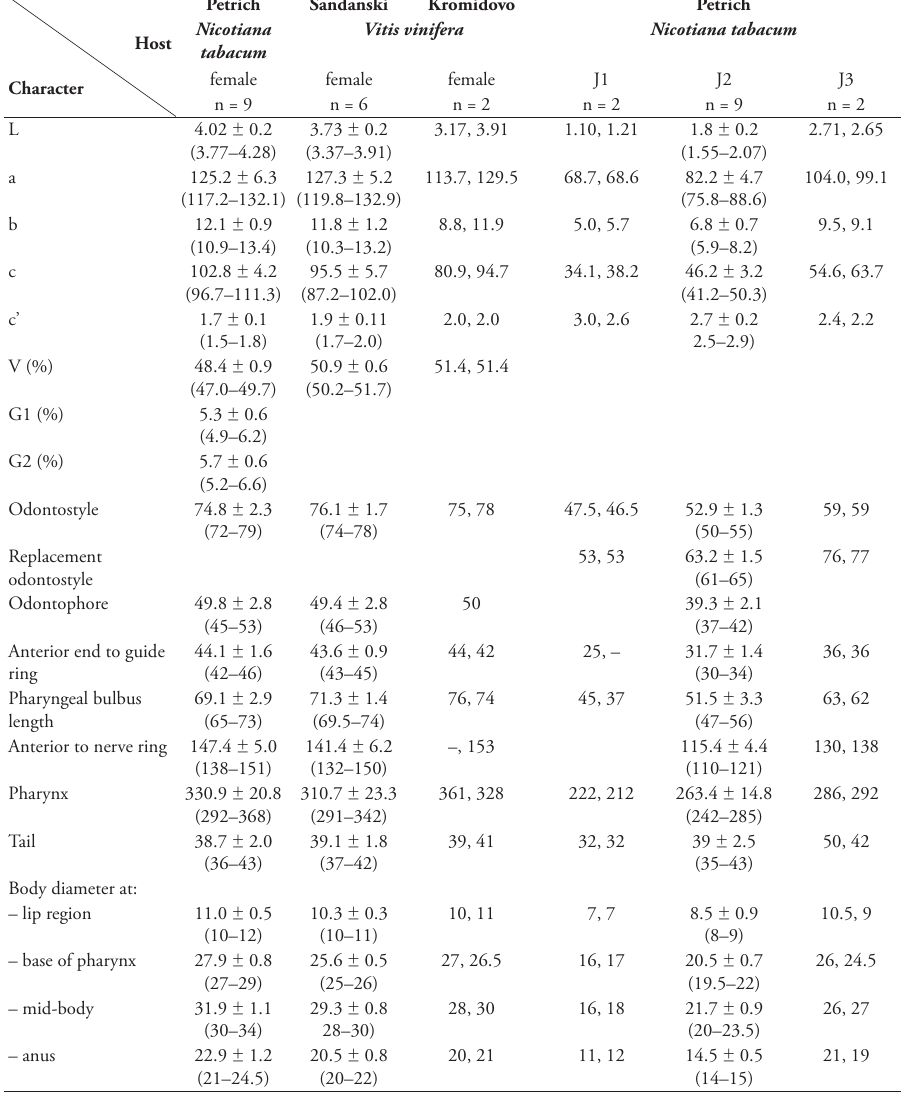
Table 4. Measurements of adults and juveniles of Longidorus pisi (mean ± standard deviation, with range) from different crops in Bulgaria. All measurements in micrometers except body length